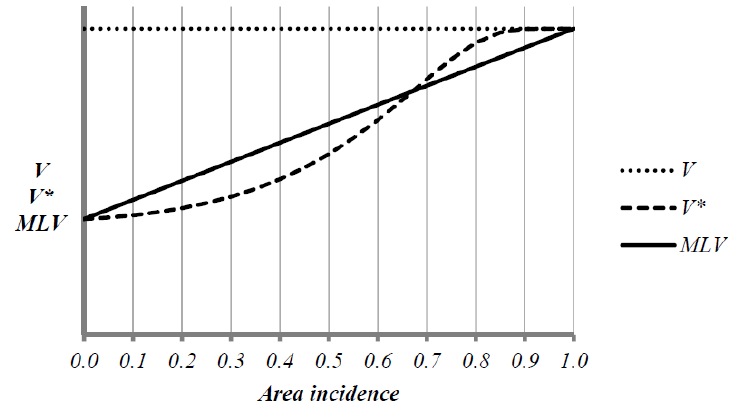
Figure 3. Relationship between V , V * and MLV and the area incidence. The bottom value and the MLV ( v L = 0.3 ; y L = 0.1 ; r = 0.06 ; r L = 0.02 ; r B = 0.077) increase when the residual life increases, and they tend to converge with longer durations (see Figure 4). The bottom value is greater than the MLV for all durations.